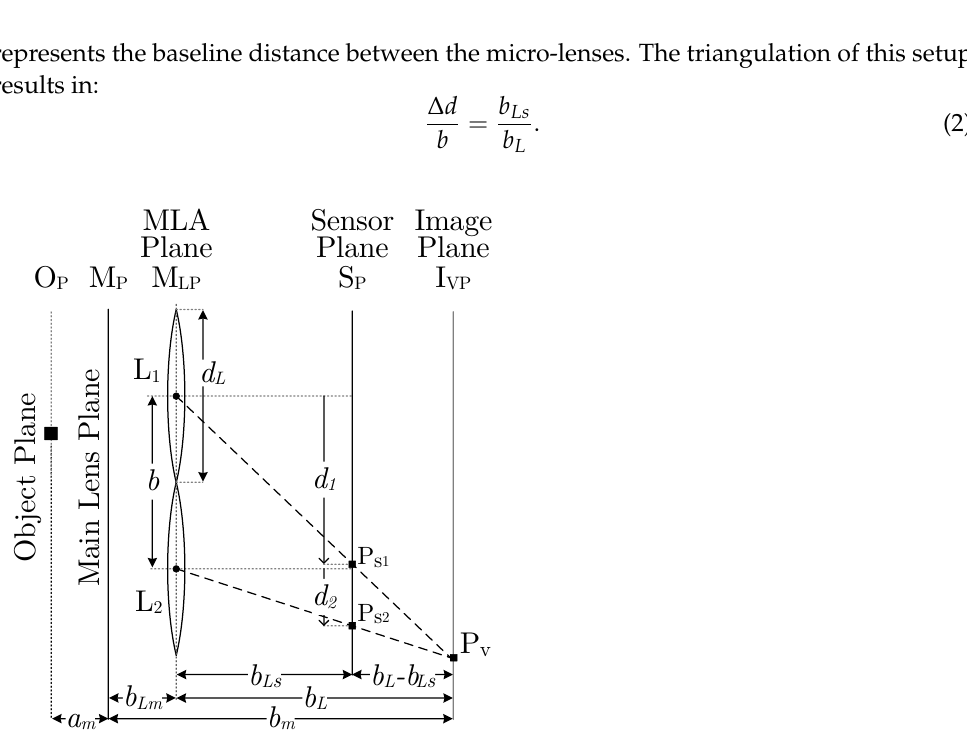
Figure 3. Plenoptic camera model with two micro-lenses and corresponding planes. Whereby ∆ d represents disparity that equals to: d 2 − d 1 . The distance of P v , rep- resented as virtual depth ( v ), is estimated with respect to intrinsic parameter b Ls of the camera that is calculated during the calibration process. Thus, v is computed by the relative distance of b L with respect to b Ls , which is only possible if the projected point is focused by minimum two